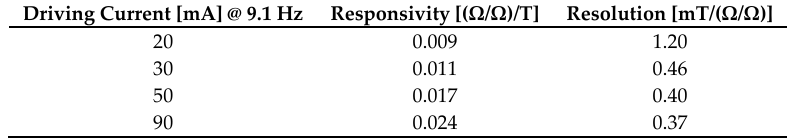
Table 2. Device responsivity and resolution for different values of the driving